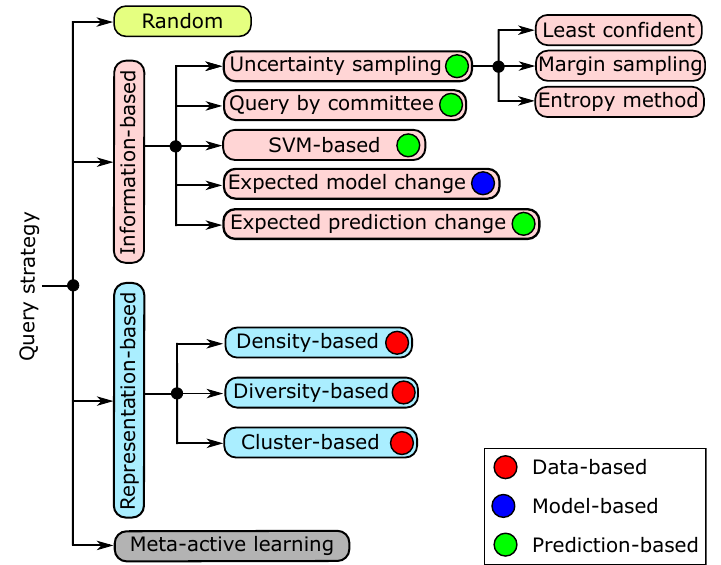
Figure 5. A taxonomy of query strategies for